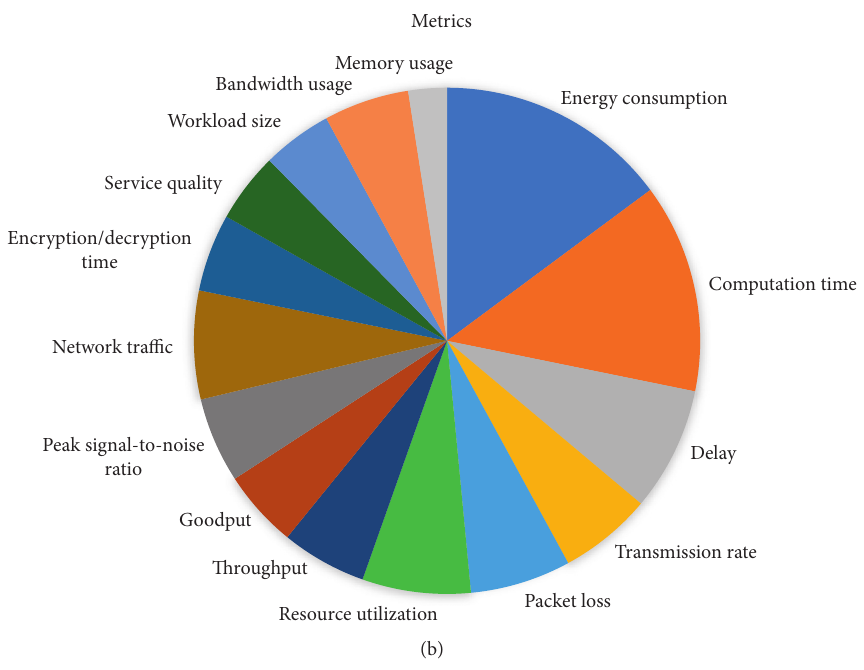
Figure 9: (a, b) Analysis of parameters/metrics used for MCC technique evaluation from the years